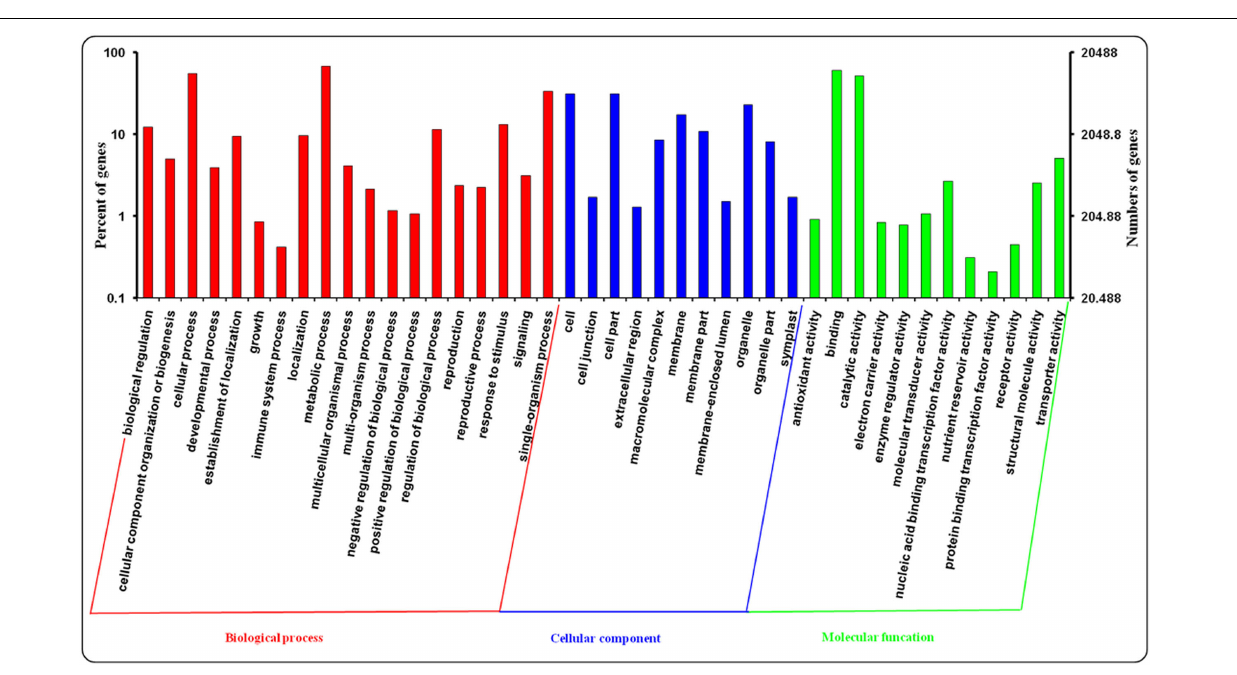
processes were underway in the leaves and roots of A. bidentata, and a variety of metabolites were